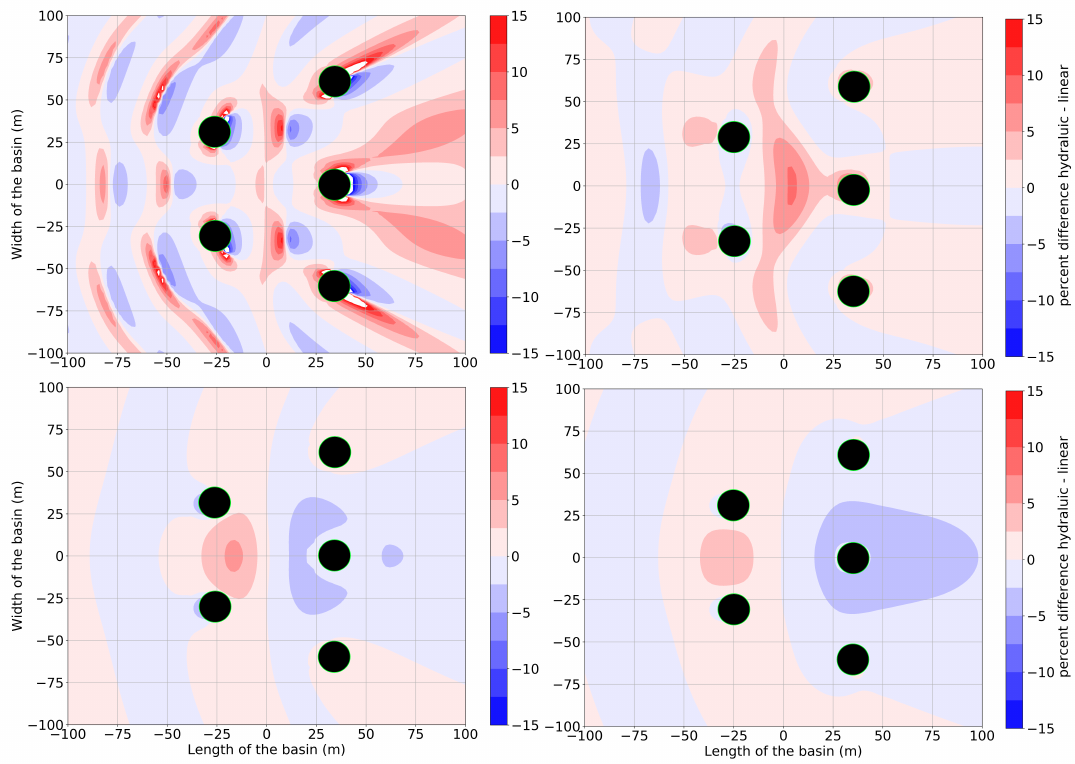
Figure 21. Percentage difference between the | η | produced by a heaving cylindrical WEC with a hydraulic PTO vs. a linear PTO system for a wave of H = 1.0 m and wave periods of T = 6.0 s ( top left ) T = 8.0 s ( top right ) T = 10.0 s ( bottom left ) T = 12.0 s ( bottom right ). Incident wave propagating from the